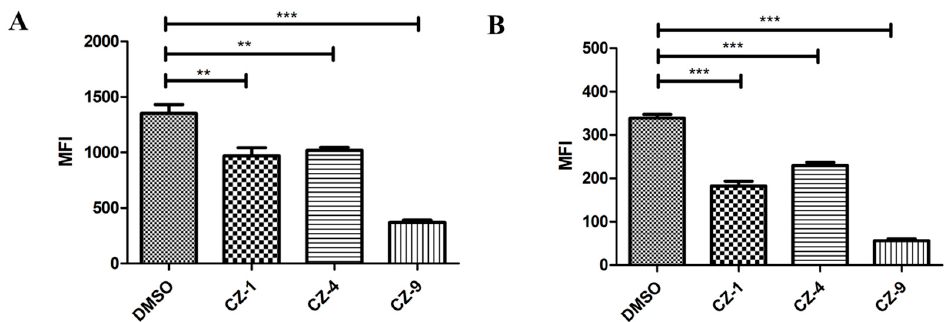
Figure 5. Promoter activities of hrpG and hrpX in Xoo grown in XOM2 supplement with 200 µ M of CZ-1, CZ-4, and CZ-9 for 15 h, measured by fluorescence-activated cell sorting (FACS). At least three independent tests were performed with similar results. Asterisks indicate statistically significant differences (Student’s t -test) ** p < 0.05, *** p < 0.01.